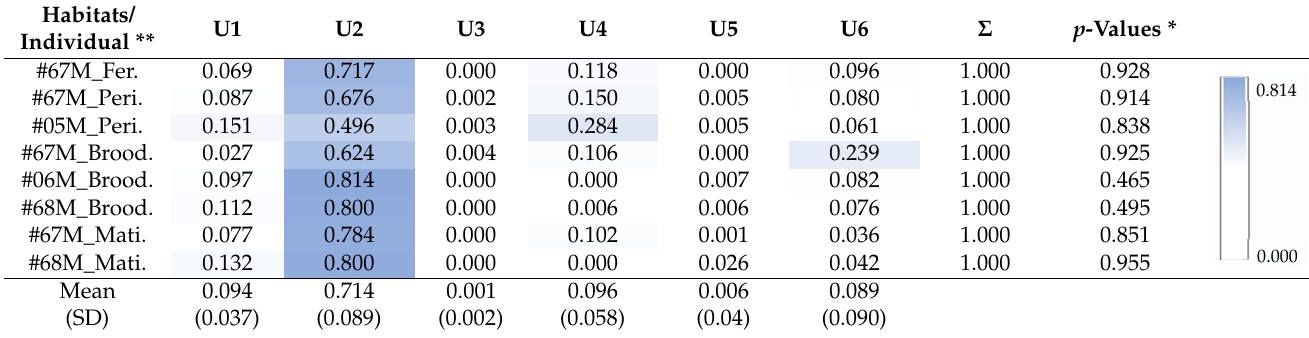
Table 4. Stationary probabilities for the habitat transitions of wild boar individuals across different life stages in different individuals according to DTMC. (Colorbar assisting visualization of probability levels.)